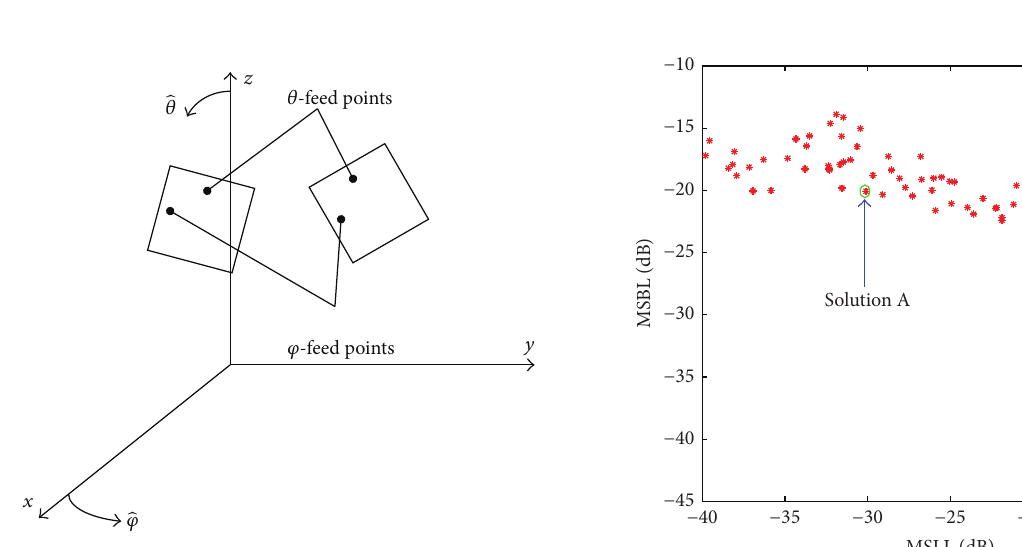
Figure 6: A graphical representation of the relations between the desired polarization vector in the main beam direction and the various components of the radiated field.